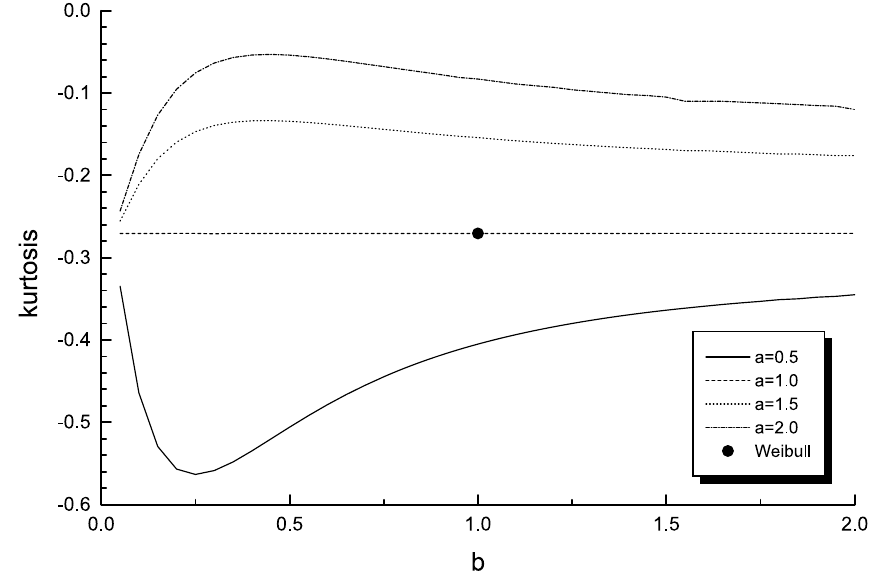
Fig. 6 – Kurtosis of the BW distribution as a function of parameter b for selected values of parameter a